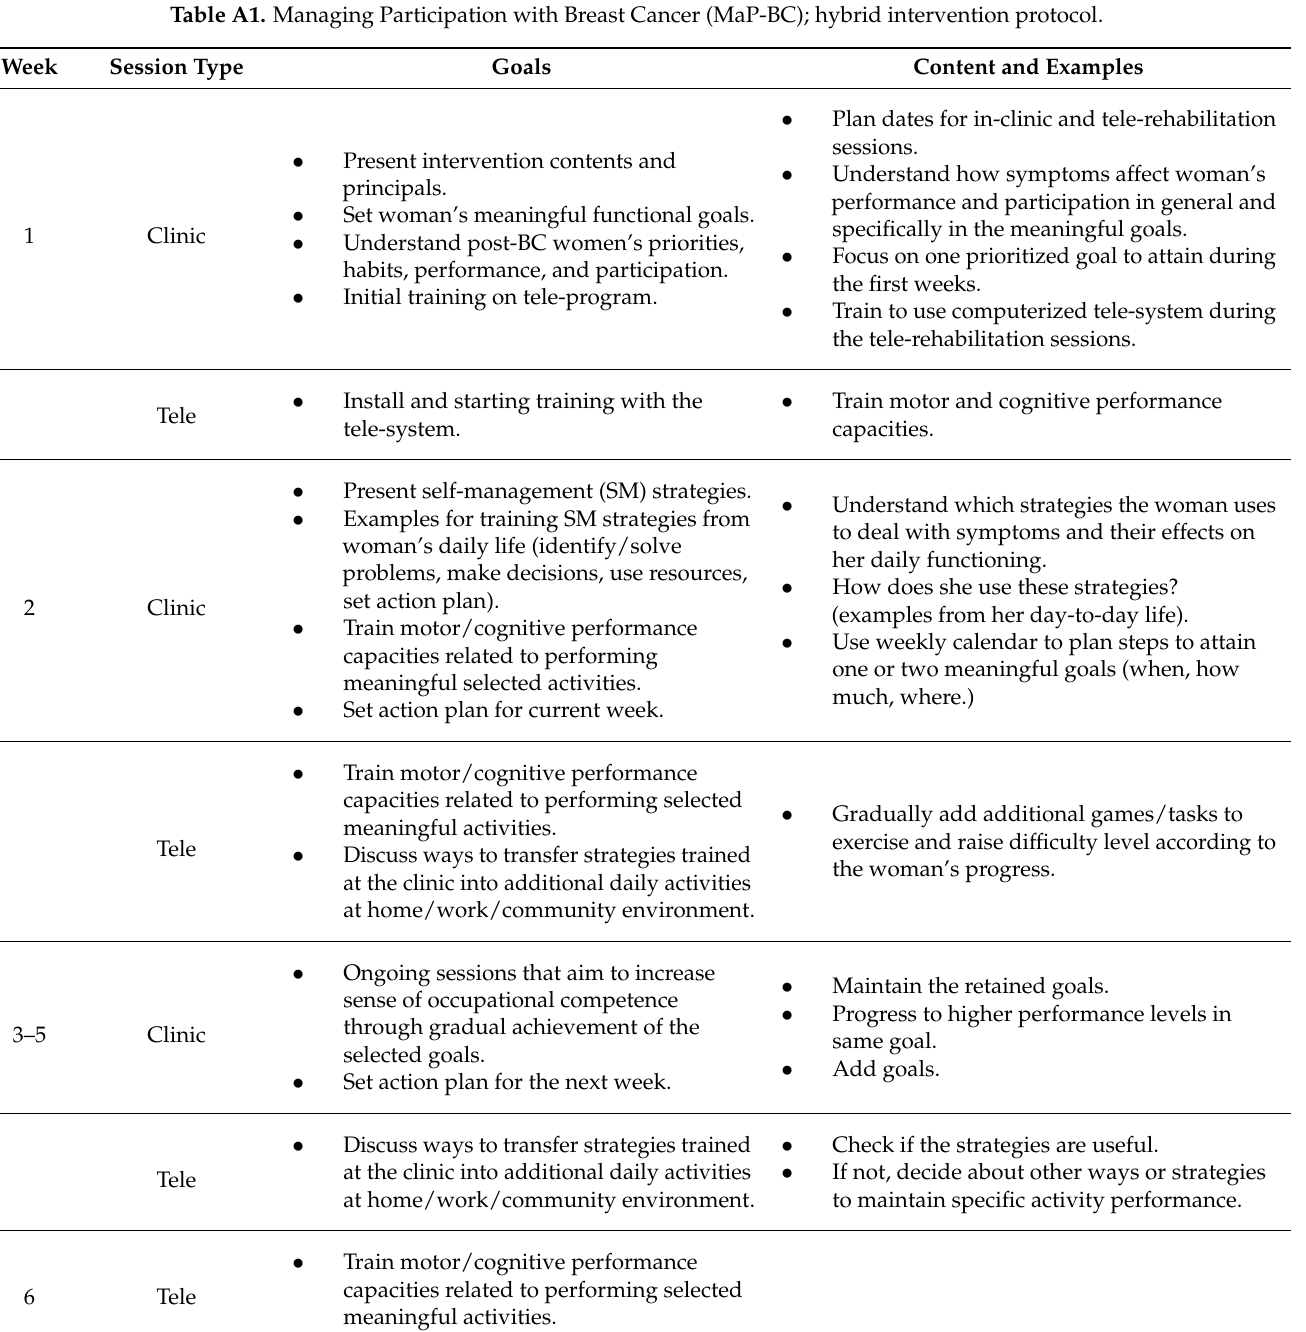
Table A1. Managing Participation with Breast Cancer (MaP-BC); hybrid intervention